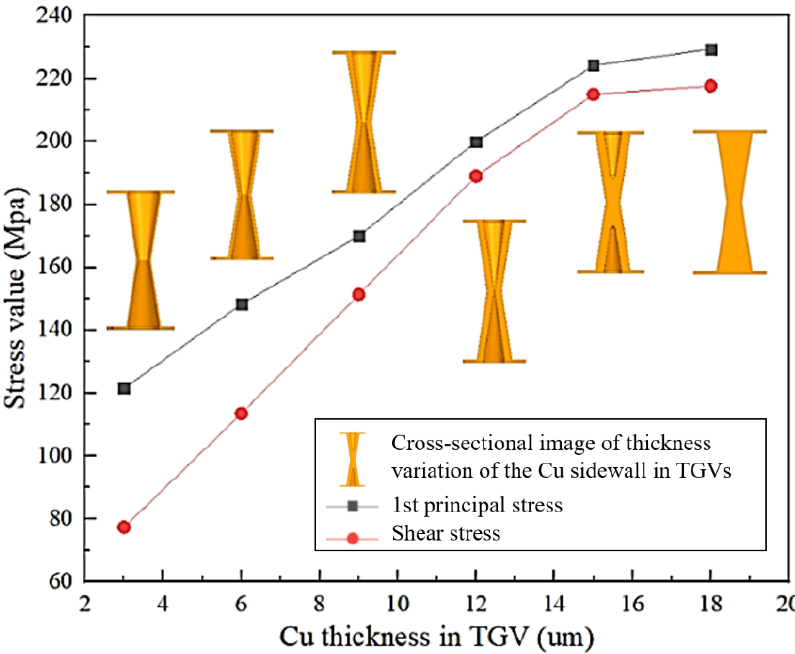
Figure 6. Effect of Cu thickness in TGV on stress evolution.